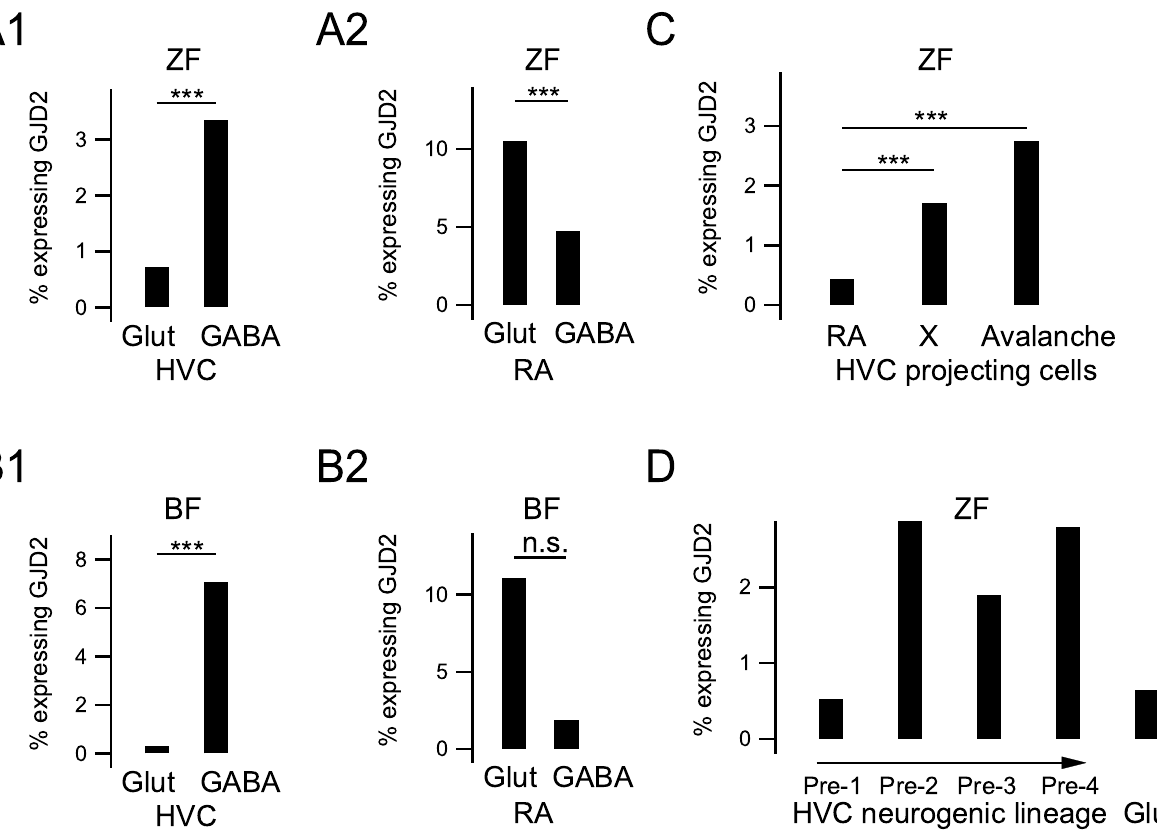
Figure 8. Fraction of GJD2-expressing neurons from single-cell transcriptomics data. Fraction of GJD2-expressing neurons in A. zebra finches (ZF) and B. Bengalese finches (BF). ( A1 , B1 ) Percentage of excitatory and inhibitory cells expressing GJD2 in HVC. ( A2 , B2 ) Percentage of excitatory and inhibitory cells expressing GJD2 in RA. ( C ) Percentage of cells expressing GJD2 in different HVC glutamatergic projection neuronal subtypes. ( D ) Percentage of cells expressing GJD2 in clusters identified as belonging to the neurogenic lineage (Pre-1 to Pre-4) and immature neurons (cluster Glut-2). The arrow indicates the progression of cells along the neurogenic lineage, from stem cells (Pre-1) to late stages (Pre-4). *** P < 0.001; n.s., nonsignificant, Fisher’s exact